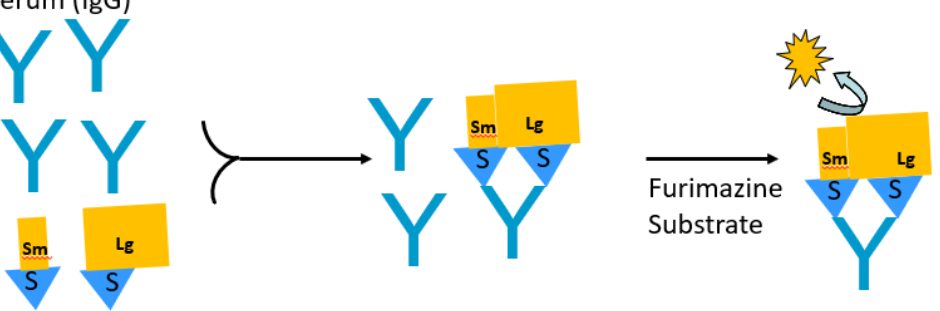
Figure 4. Split Nano Fab binding immunoassay for detecting antibodies. In this assay, purified antigen fusion proteins of SmBiT and LgBiT Nano fragments are incubated with serum samples. Shown is an immunoassay employing the SARS-CoV-2 spike (S) protein with the SmBit and LgBiT. If a spike antibody is present, in some cases, an antibody with one Fab arm binds to the LgBit sensor and the other Fab arm binds to the SmBit sensor. This binding of the two Fabs of a spike antibody to both the SmBit and LgBit Nano fragments reconstitutes Nano and produces a luciferase signal output, in which the amount of specific antibody present is proportional to the light produced. Antibody molecules that have bound only two molecules of SmBiT or only two molecules of LgBiT do not complement and do not produce detectable luciferase activity (not shown).